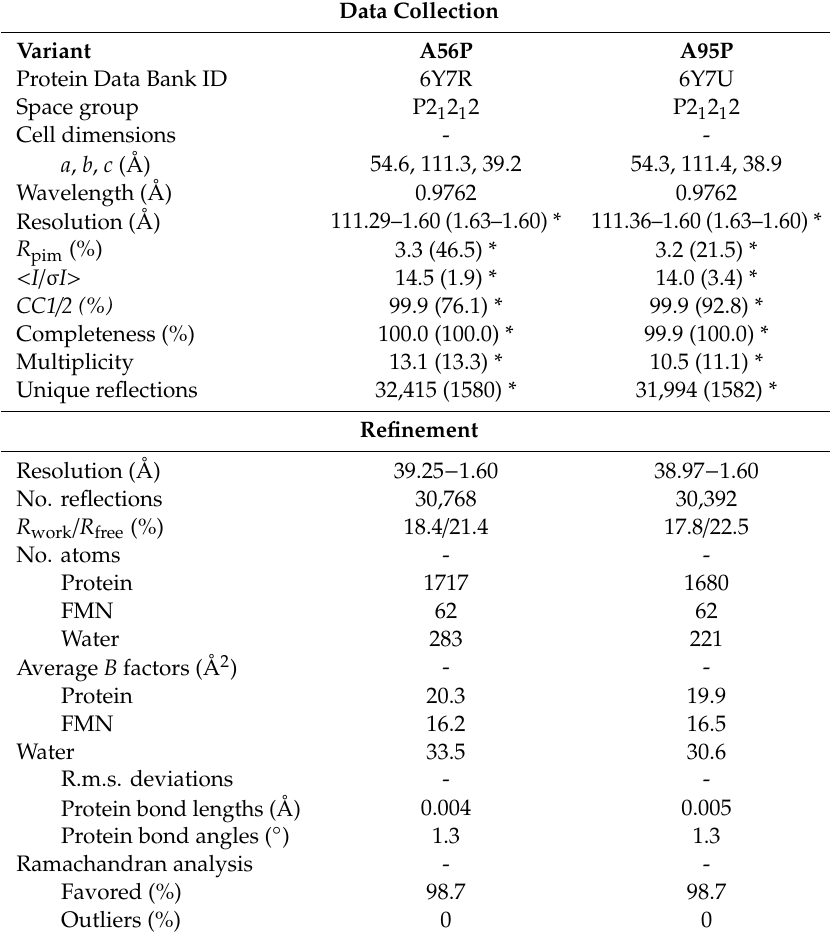
Table 2. Crystallographic data collection and refinement statistics. R.m.s.: root mean